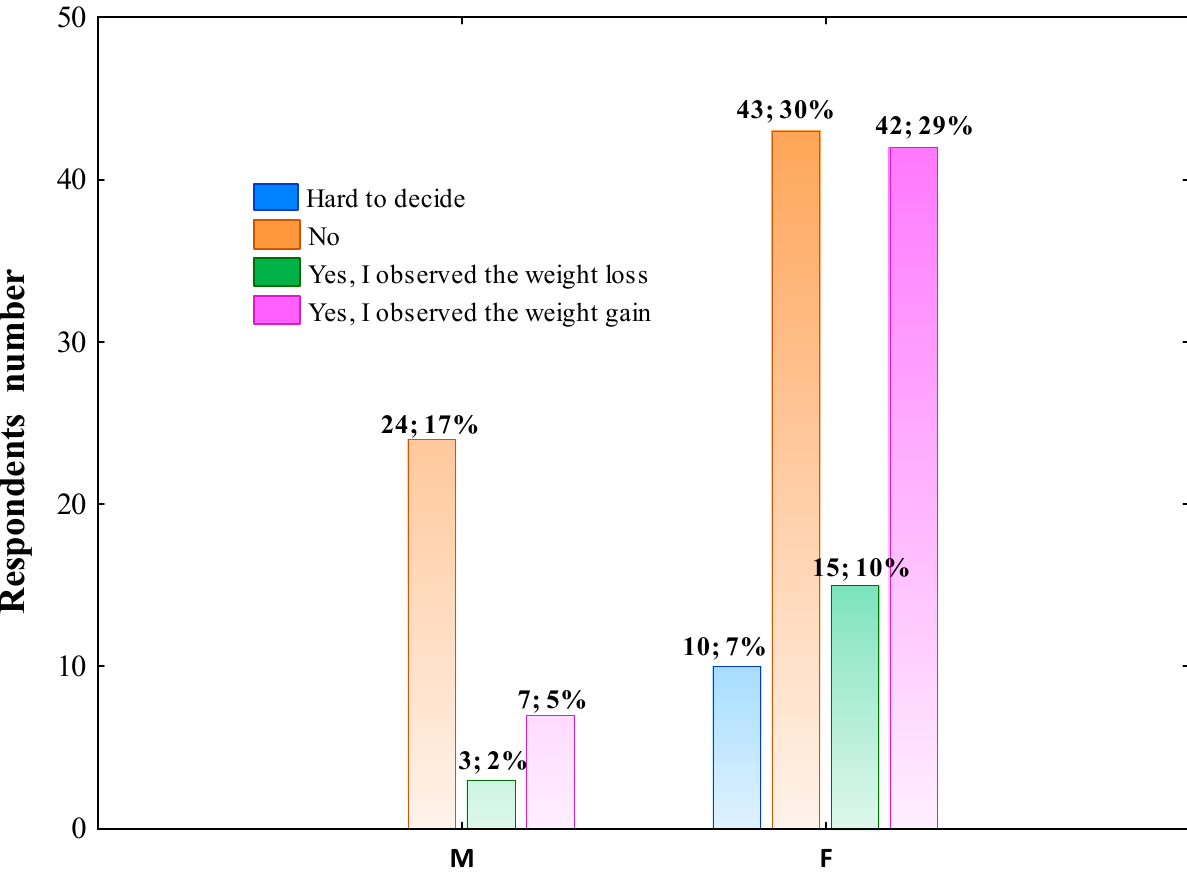
Figure 4. The effect of pandemic COVID-19 on body weight change across gender groups (M–men; F–female). The column description includes the respondents’ number in this gender who chose such an answer, followed by the percentage of the total respondents. Data were analyzed using Pearson’s chi-squared test. Pearson’s χ 2 = 11.473; df =3; p = 0.0094; n = 145.